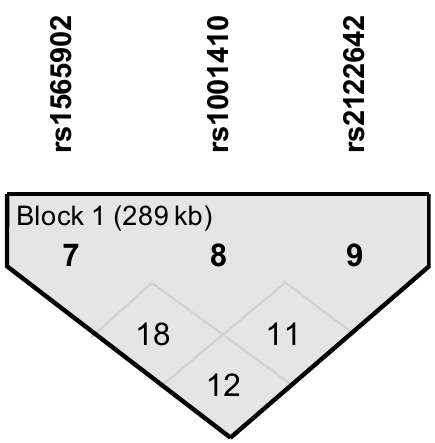
Figure 1. Linkage disequilibrium blocks for haplotype-based association analyses in 113 nuclear families segregating ADHD from a Caribbean community. See Table 3b for more information.